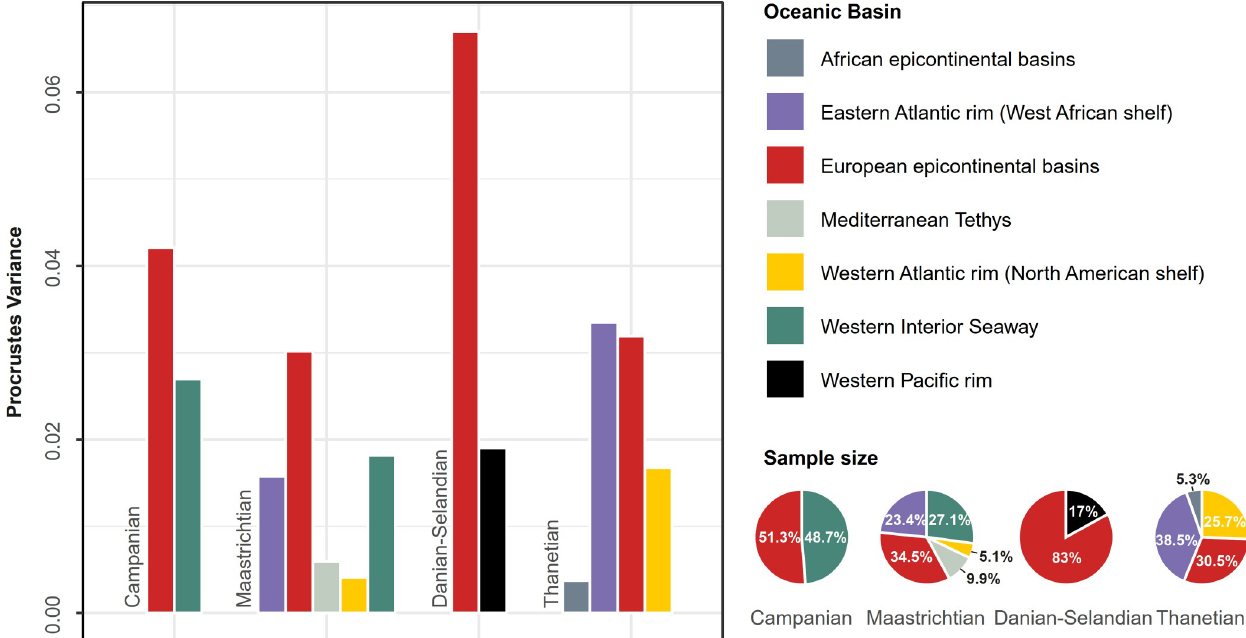
Fig 6. Geographic distribution of disparity. Mesozoic marine depositional basins are based on Wretman and colleagues [75]. Basins with sample sizes of N < 10 were omitted. Pie graphs depict sample proportions. The data used in this analysis can be accessed online at https://doi.org/10.5061/dryad.c866t1g5n.